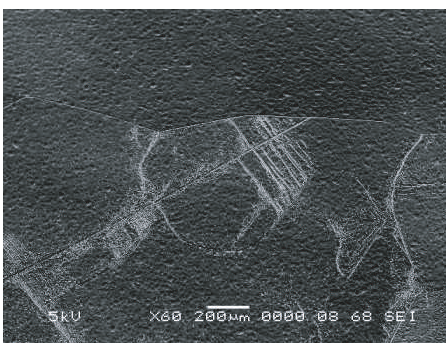
Figure 1: Crystalline defects delineated by Secco etch on mc-Si.